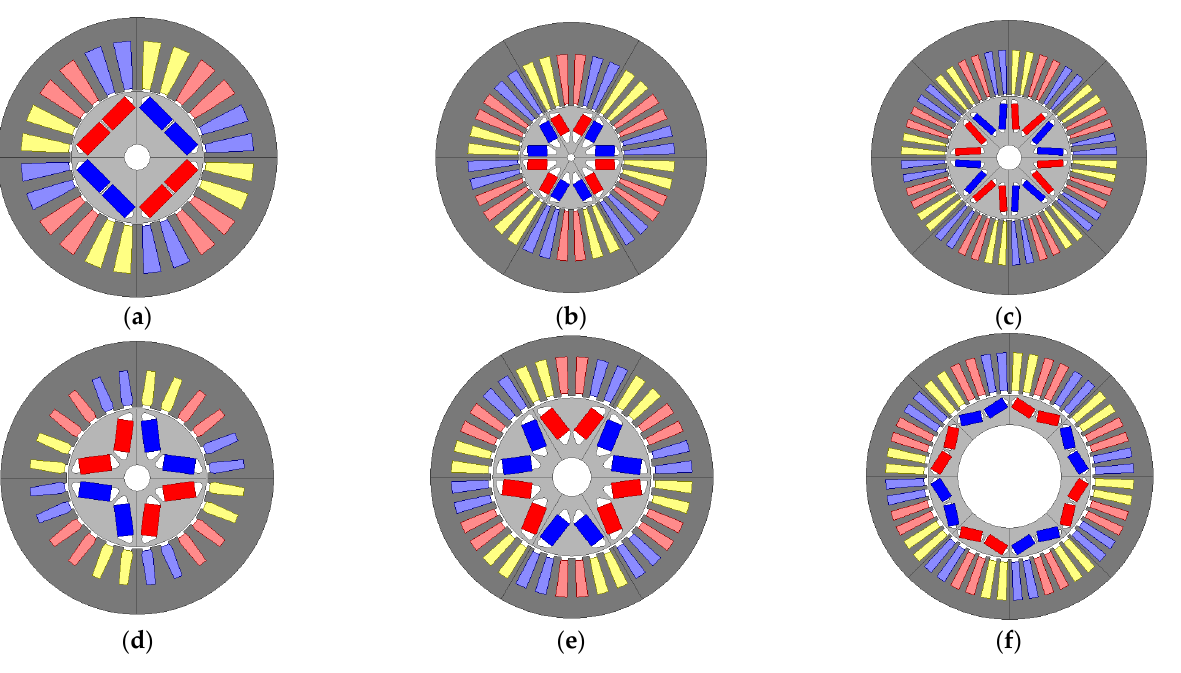
Figure 15. ( a ) 𝑀 (cid:2872)(cid:2868)(cid:2879)(cid:2870)(cid:2879)(cid:3004)(cid:3021)∗ , ( b ) 𝑀 (cid:2872)(cid:2868)(cid:2879)(cid:2871)(cid:2879)(cid:3004)(cid:3021)∗ , ( c ) 𝑀 (cid:2872)(cid:2868)(cid:2879)(cid:2872)(cid:2879)(cid:3004)(cid:3021)∗ , ( d ) 𝑀 (cid:2872)(cid:2868)(cid:2879)(cid:2870)(cid:2879)(cid:3015)(cid:3021)∗ , ( e ) 𝑀 (cid:2872)(cid:2868)(cid:2879)(cid:2871)(cid:2879)(cid:3015)(cid:3021)∗ , ( f ) 𝑀 (cid:2872)(cid:2868)(cid:2879)(cid:2872)(cid:2879)(cid:3015)(cid:3021)∗ . For classic technologies, the machine with p = 2 has the highest power density (30.3 kW/L), unlike previous values of maximum rotational speed for CT-based machines, with excellent efficiency at point 1 (96.9%) and medium efficiency at point 2 (92.6%). Its main disadvantages compared to other pole pairs are the highest amount of copper (42.6 g/kW) and magnets (13.4 g/kW). The machine with p = 4 has low power density (25.5 kW/L), good efficiency at point 1 (96.8%), low efficiency at point 2 (93%), the lowest amount of copper (32.4 g/kW), and high amount of magnets (12.7 g/kW). To respect the voltage constraint, the machine with p = 4 has one turn, resulting in a low magnet flux. The current density is limited to 14.2 Arms/mm 2 because of the current reaching its maximal value defined in specifications. The low number of turns leads to a low magnet flux and ampere- turns; hence, the optimization chooses a higher active length to achieve the required torque. The maximum active length initially defined as 200 mm has been increased to 210 mm for machines with p = 4 to reach the required torque. This results in a larger machine and, therefore, lower power density. With a single turn, the resistance per phase is low, which results in lower joule losses (2 kW at point 1). The latter is dominant at low speed; therefore, total losses at point 1 of the machines with p = 4 are low. Moreover, a small number of turns induces more iron losses [40] at point 1 (1 kW) and point 2 (4.6 kW). The latter being dominant at high speed explains the high total losses at point 2 for the machine with p = 4. The machine with p = 3 has low power density (25kW/L), good efficiency at point 1 (96.3%) and point 2 (95.3%), a medium amount of magnets (11.6 g/kW), and a high amount of copper (43.3 g/kW). It has two turns, which allows more ampere-turns. Therefore, the optimization slightly increases the current density to 14.4 Arms/mm 2 and increases the slot’s surface thanks to the high outer radii of the stator. Furthermore, a higher number of turns means a higher resistance per phase and, therefore, higher joule losses (2.8 kW at point 1). The latter being dominant at low speed, total losses at point 1 of the machine with p = 3 are therefore